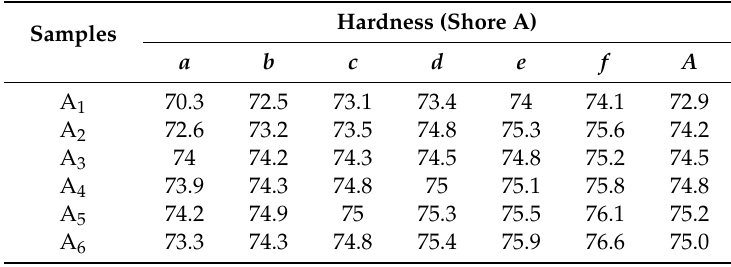
Table 2. Hardness test results of samples from Factory